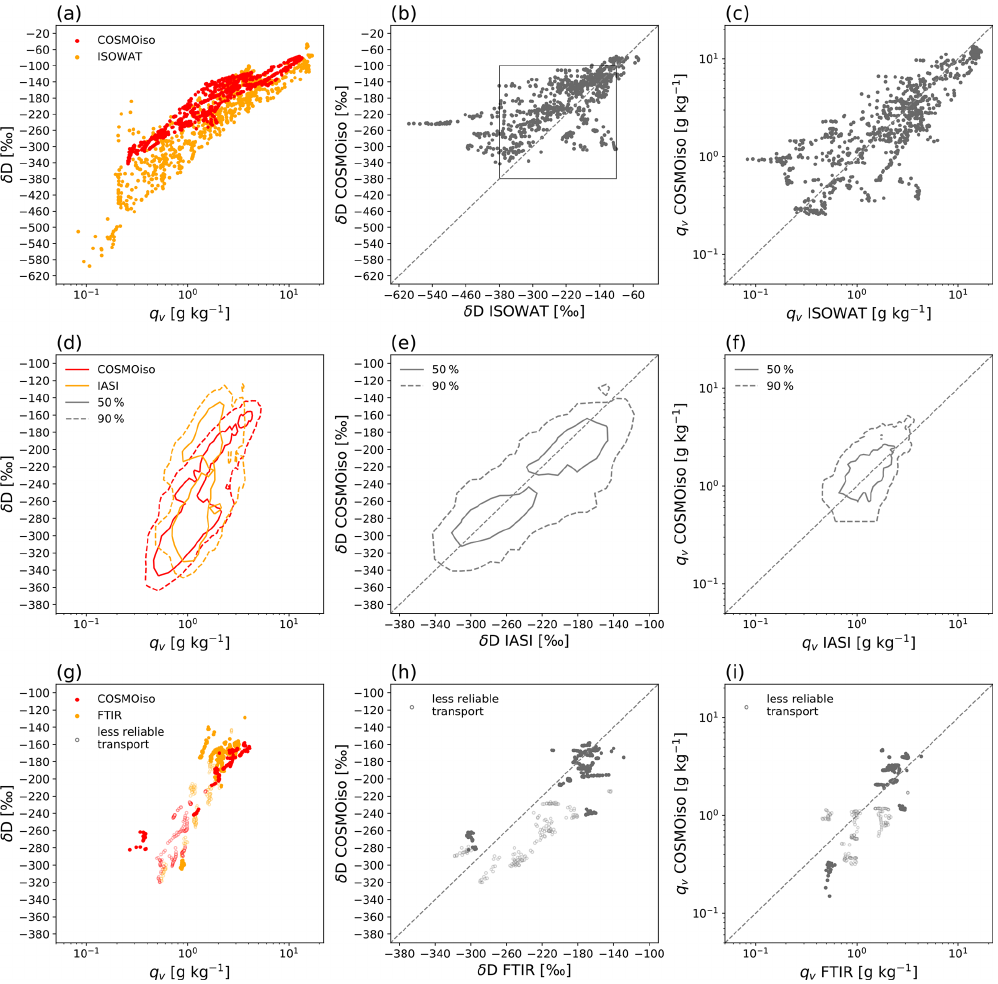
Figure 5. Comparison of COSMO iso q v and δ D in water vapour with multi-platform observations over the subtropical North Atlantic near Tenerife: (a–c) comparison with airborne in situ ISOWAT measurements performed between sea level and 7km altitude during 7 flight days in July and August 2013, (d–f) comparison with satellite-based IASI remote sensing observations retrieved for 4.2km in a 10 ◦ × 10 ◦ box centred around Tenerife during 32d July and August 2013, and (g–i) comparison with ground-based FTIR remote sensing observations retrieved for 4.9km during 25d in July and August 2013. Solid and dashed contours in (d–f) show the 50% and 90% frequency isolines of normalised two-dimensional histograms. Empty circles in (g–i) indicate a less reliable air parcel transport (see Sect. 2.4). The black box in (b) represents the δ D space of (e, h)